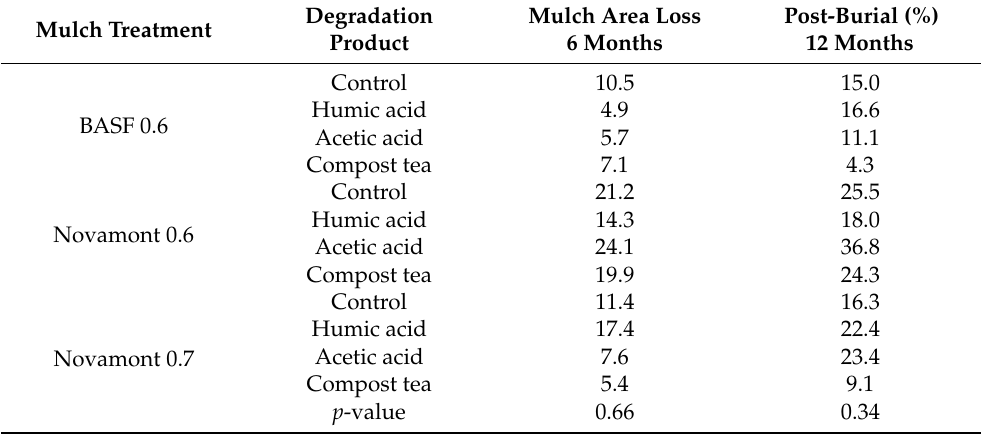
Table 7. Mulch surface area loss of soil-biodegradable plastic mulch treatments (BASF 0.6, Novamont 0.6 and Novamont 0.7, where 0.6 = 15.2 µ m thickness and 0.7 = 17.8 µ m thickness) 6 and 12 months after burial in nylon decomposition bags. Burial took place in June 2020 in the corresponding split-split plots at a depth of 10 cm. A faba bean ( Vicia faba L.) cover crop was seeded over the decomposition bags at a planting density of 168 kg/ha after